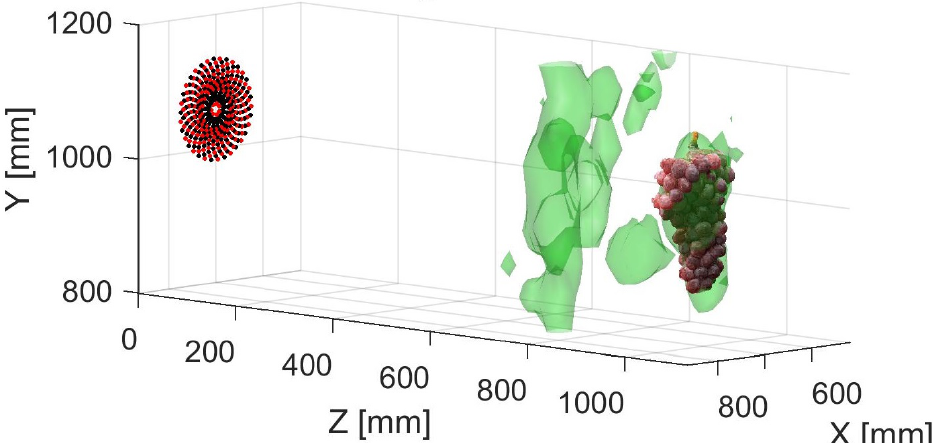
Figure 15. Isosurface visualisation of near-field RX beamformed and TX distortion compensated acoustic scan with averaging of 20 recordings at each scan point. The additional level of detail can be clearly seen in the focused RMS volume.